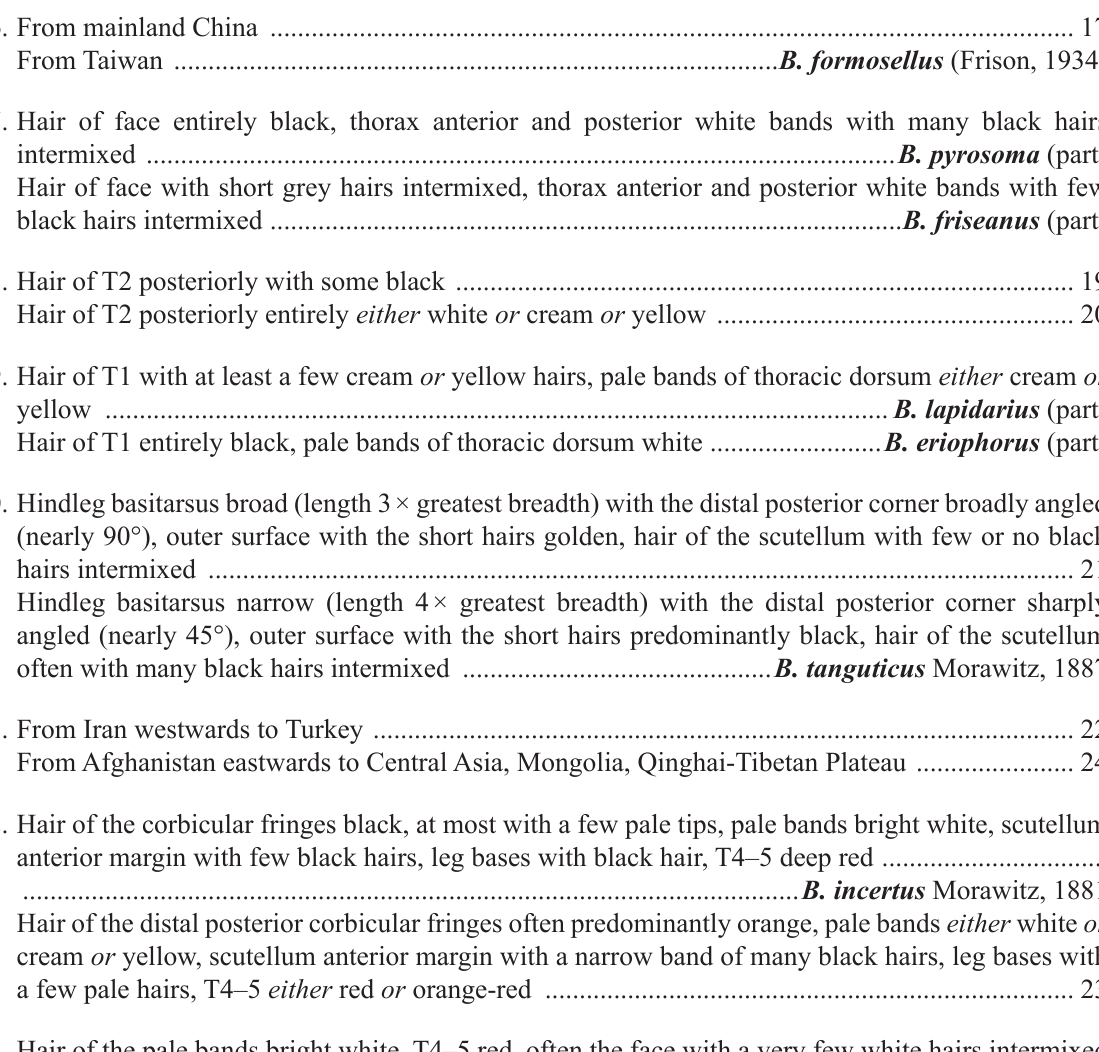
– From Afghanistan eastwards to Central Asia, Mongolia, Qinghai-Tibetan Plateau ....................... 24 22. Hair of the corbicular fringes black, at most with a few pale tips, pale bands bright white, scutellum anterior margin with few black hairs, leg bases with black hair, T4‒5 deep red ................................ – Hair of the distal posterior corbicular fringes often predominantly orange, pale bands either white or cream or yellow, scutellum anterior margin with a narrow band of many black hairs, leg bases with a few pale hairs, T4‒5 either red or orange-red ............................................................................. 23 23. Hair of the pale bands bright white, T4‒5 red, often the face with a very few white hairs intermixed and T2 posteriorly with a very few black hairs intermixed (Iran) ............................ B. sichelii (part) – Hair of the pale bands white or cream or yellow, T4‒5 orange-red, the face entirely black and T2 24. [NB couplets 24–29 may be reliable only for queens and not for workers] Hair of the pale bands – 25. Hair of the side of the thorax in its lower half with some pale hair and T3 laterally with a few pale hairs, scutellum with a narrow anterior band entirely black but usually covering less than half of the length of the scutellum (Central Asia, Mongolia) .......................................................................... 26 – Hair of the side of the thorax in its lower half entirely black and T3 entirely black, scutellum with the anterior half entirely black (Mongolia) ................................................ B. incertoides Vogt, 1911 26. Hair of face entirely black, T3 more often with a few pale hairs usually only laterally, leg bases more often with many black hairs, T4‒5 uniformly orange-red (Central Asia, northwest